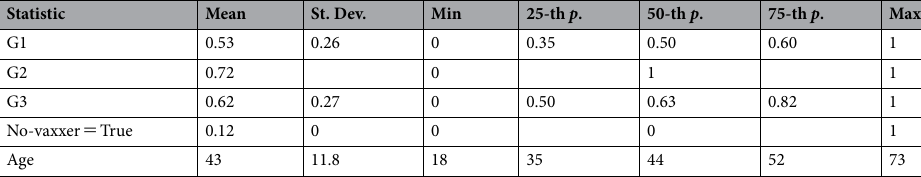
Table 2. Descriptive statistics of the variables considered in the statistical analysis. The number of observations (i.e., individuals) is 1482. In the 3 treatments T1, T2 and T3 there were 497, 512 and 473 individuals,